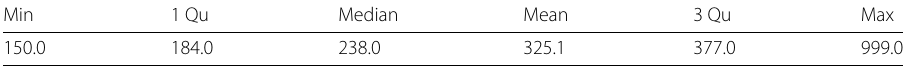
Table 4 The distribution of the combined score according to the STRING data base